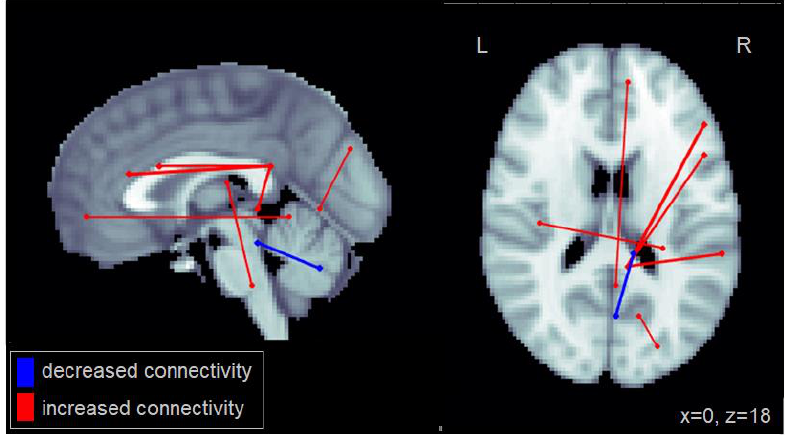
Figure 2. Altered functional connectivity associated with number of lane deviations observed among patients with MCI. Blue lines denote functional connections with reduced connectivity associated with greater lane deviations, red lines denote increased connectivity (significant at FDR = 0.05). Connections are shown as projections in the sagittal and axial plane, with MNI anatomical underlays (slices at x = 0 and z = 18 respectively).